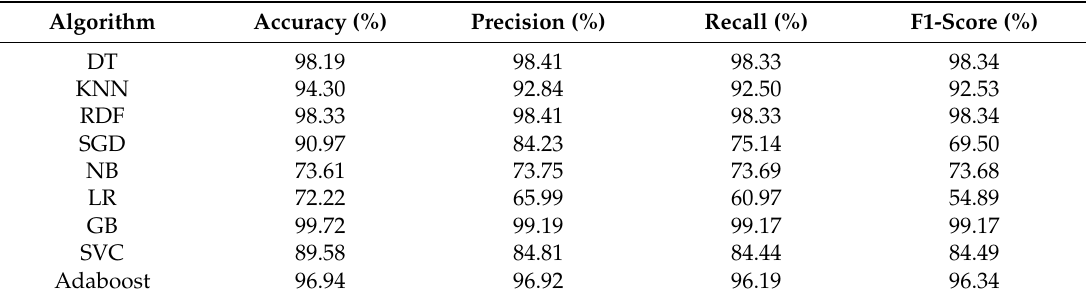
Table 8. Global performance comparison of ML models using dissipation factor (D) features.